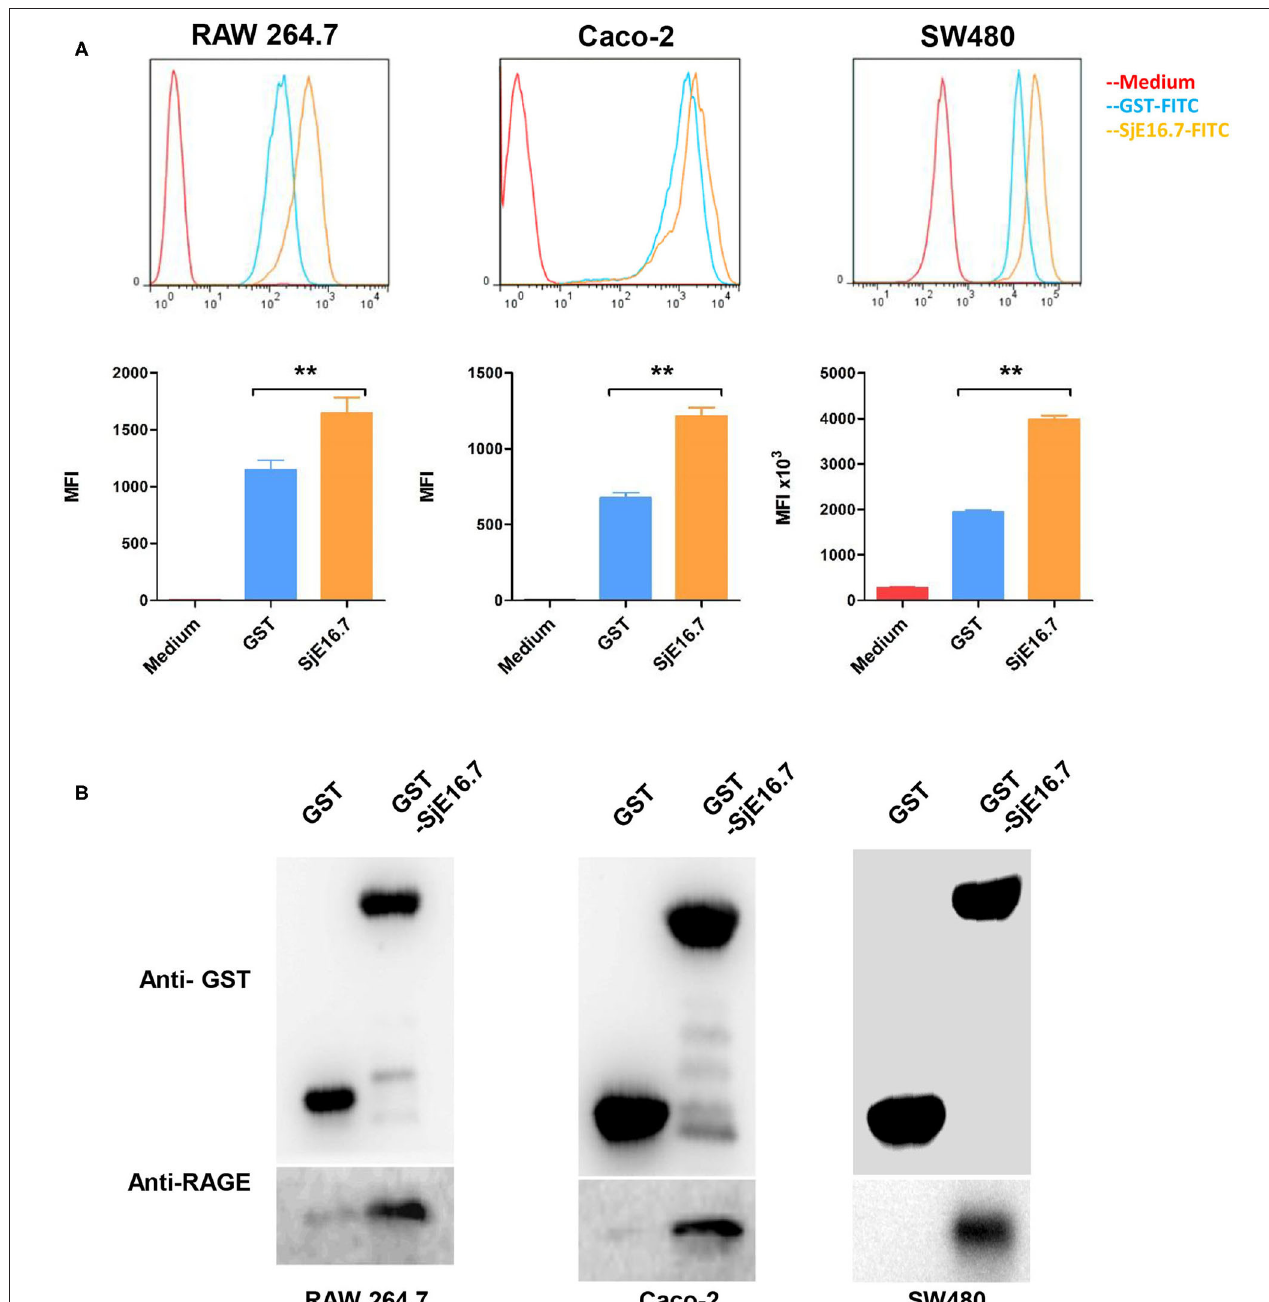
FIGURE 1 | SjE16.7 binds to RAGE. (A) FITC-labeled SjE16.7 or control FITC-GST protein binding to RAW 264.7, Caco-2, and SW-480 cells was measured by flow cytometry. Pooled data from two independent experiments are shown. MFI, Mean Fluorescence Intensity. ** p < 0.01 FITC-SjE16.7 group compared with FITC-GST group. (B) RAW 264.7, Caco-2, and SW-480 cell lysates were prepared and pulled down with GST or GST-SjE16.7 sepharose beads. Protein on beads and in total cell lysates was subjected to Western blot to determine the levels of bound RAGE. The experiments were repeated at least three times with similar results.